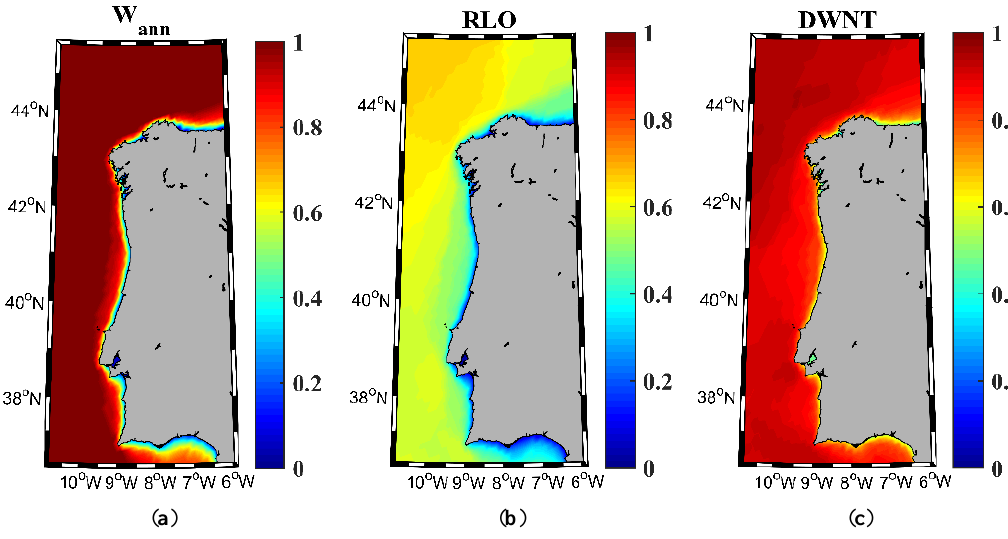
Figure 2. Richness indices for wind energy resource. Annual average wind speed ( a ), rich level occurrence ( b ), and downtime ( c ) in the NW Iberian Peninsula for the near future (2026–2045).